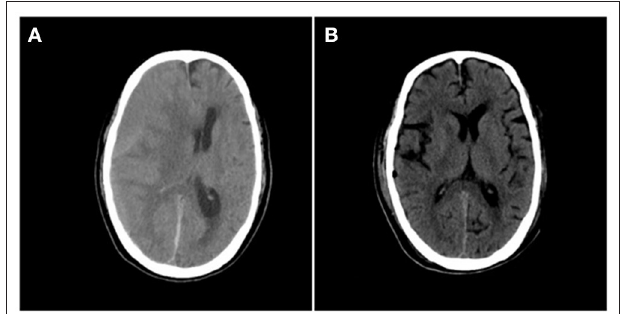
FIGURE 1 | (A) Preoperative CT showing a crescent-shaped slightly dense shadow under the right cranial plate, with displaced midline structures and lateral ventricular compression. (B) Postoperative brain CT reexamination showing complete hematoma clearance without secondary bleeding.